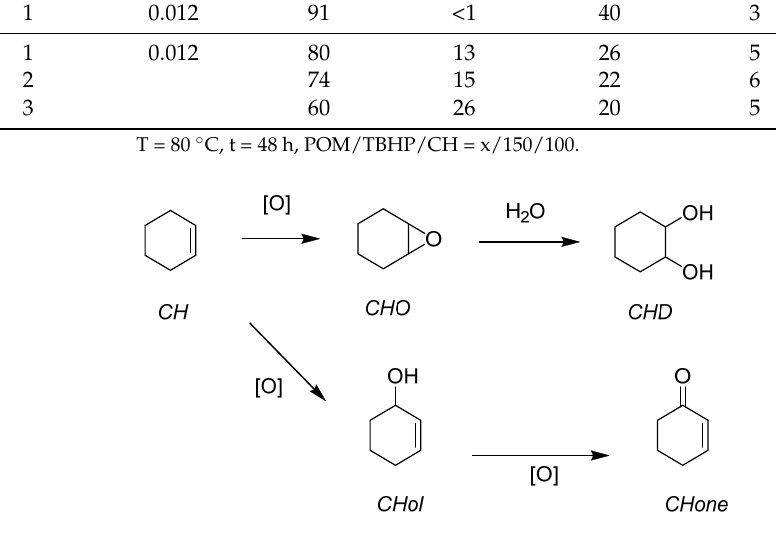
Figure 26. CH epoxidation and studied species. Table 15. Lim epoxidation with heteropolyacids and corresponding anionic species from Figure 24. Analyzed species can be found in Figures 16 and 18.